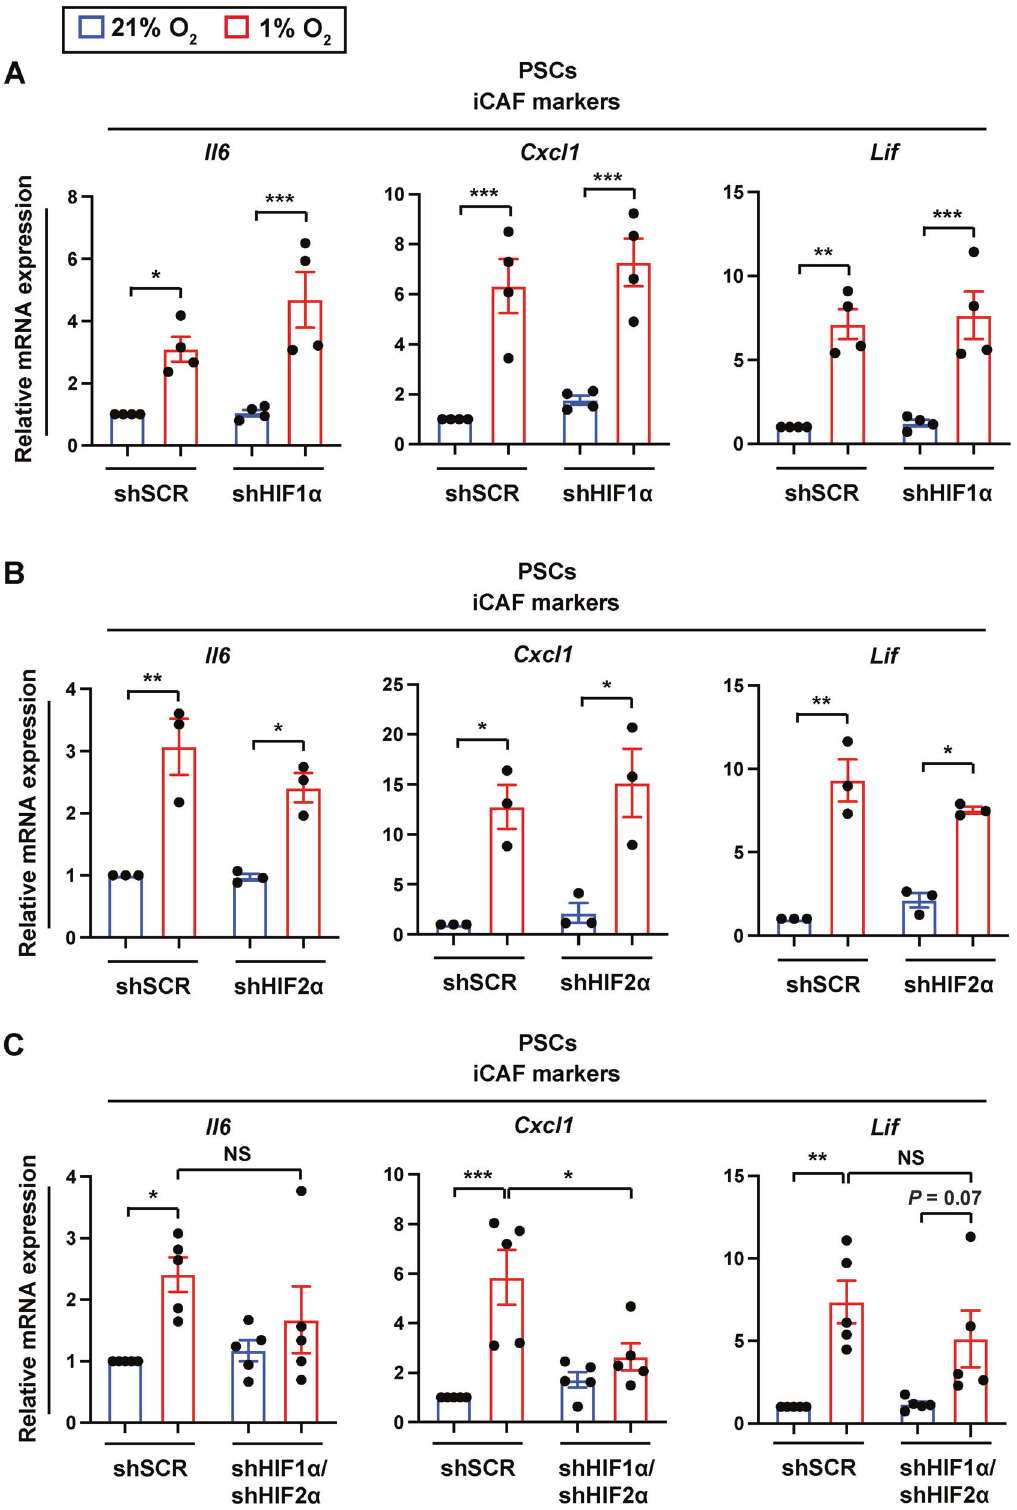
Fig. 3 Hypoxia induces in fl ammatory fi broblasts in a tumor HIF-independent manner. Quantitative RT-PCR analysis of iCAF markers in PSCs cultured with mT3 tumor organoids expressing scrambled shRNA (shSCR) control, HIF1 ɑ shRNA (shHIF1 ɑ ) ( A ), HIF2 ɑ shRNA (shHIF2 ɑ ) ( B ), or both shHIF1 ɑ and shHIF2 ɑ ( C ) under 21% O 2 or 1% O 2 for 48 h ( n = 4 shHIF1 ɑ , n = 3 shHIF2 ɑ , n = 5 shHIF1 ɑ /shHIF2 ɑ ). Expression levels were normalized by 18S rRNA . Each data point represents individual primary PSC lines. Results show mean ± SEM. P- values were determined by two- way ANOVA with Bonferroni post-test. NS not signi fi cant. * p < 0.05; ** p < 0.01; *** p <